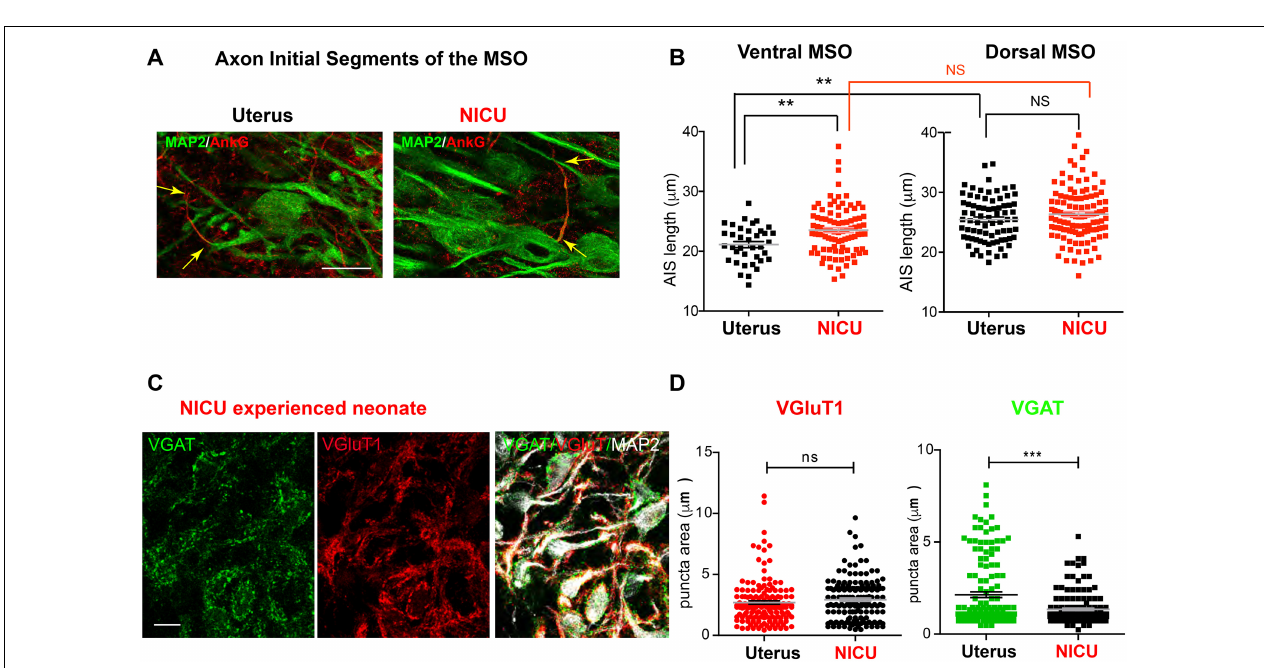
FIGURE 7 | Two-week NICU stay influences structural development of the MSO in baboon neonates. (A) Axon initial segments of MSO neurons were immunolabeled with AnkG (red) and MAP2 in neonates delivered normally at 140d GA (with maternal auditory experience in uterus; Uterus), and age-matched neonates delivered at 126d with a 2-week postnatal stay in the NICU (NICU). Scale = 20 µ m. Arrows indicate the AIS, which was stained with AnkG. (B) Comparison of AIS length of MSO neurons in the ventral and dorsal MSO in the two groups (Uterus vs NICU). (C) Immunostaining for VGluT1 (red) and VGAT (green) puncta on MSO neurons (MAP2) in neonates with a NICU stay. Scale = 20 µ m. (D) VGluT1 (red) and VGAT (green) puncta area in the MSO from neonates with a NICU stay (NICU) vs in the uterus (Uterus). ** < 0.01 and *** < 0.001, unpaired t